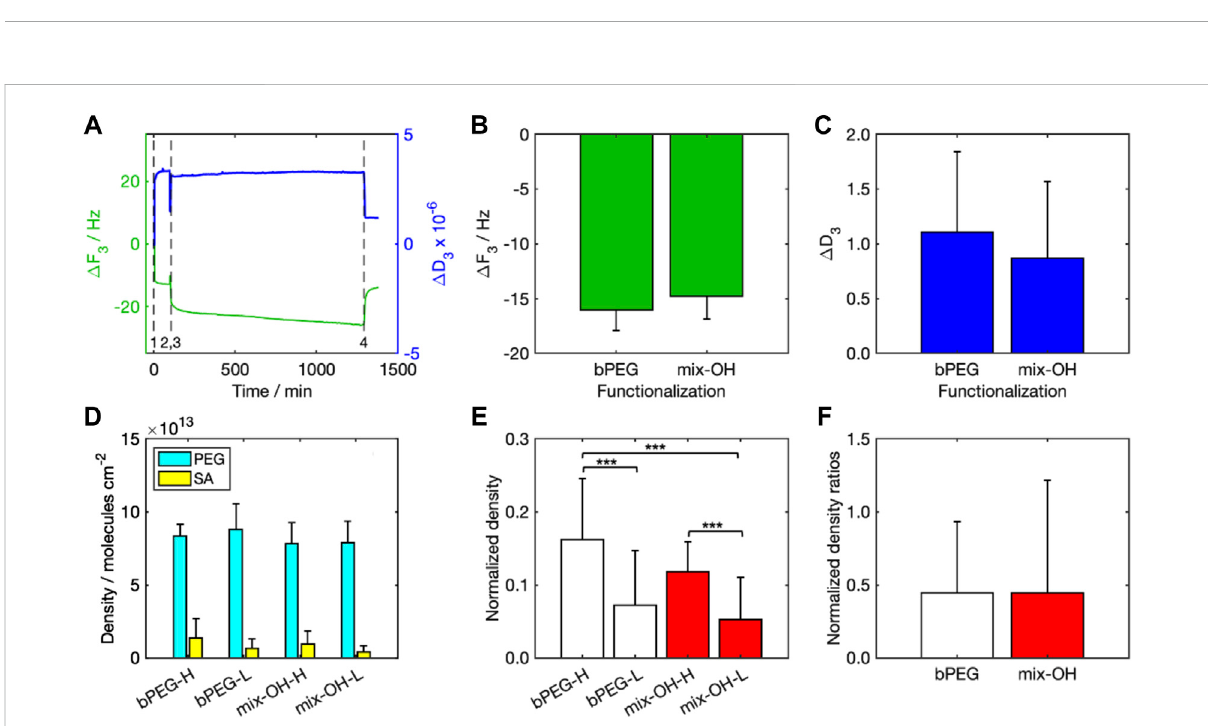
FIGURE 4 ResultsofQCM-Danalysis: (A) Δ F3and Δ D3overtime(event1:PEGinjection,event2:PEGrinsing,event3:SAinjection,event4:SArinsing), (B) valuesof Δ F3,and (C) Δ D3(afterrinsing)forbPEGandmix-OHfunctionalization, (D) densityofmoleculespercm 2 calculatedforthefunctionalization layer and bound SA in all experiments, (E) normalized density calculated for both functionalizations, bPEG- and mix-OH indicate the functionalization layer while letters H and L indicate the concentration of SA in the sample. The symbol *** indicates a statistical signi fi cance with p < 0.001 (Tukey – Kramer test), (F) ratios between the normalized densities calculated for both SA